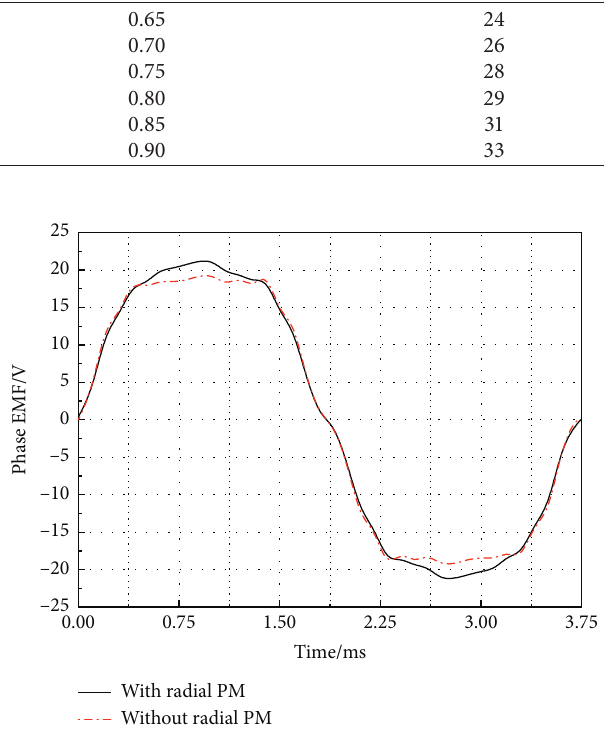
Figure 10: EMF of the PMCHEG only with permanent magnetic